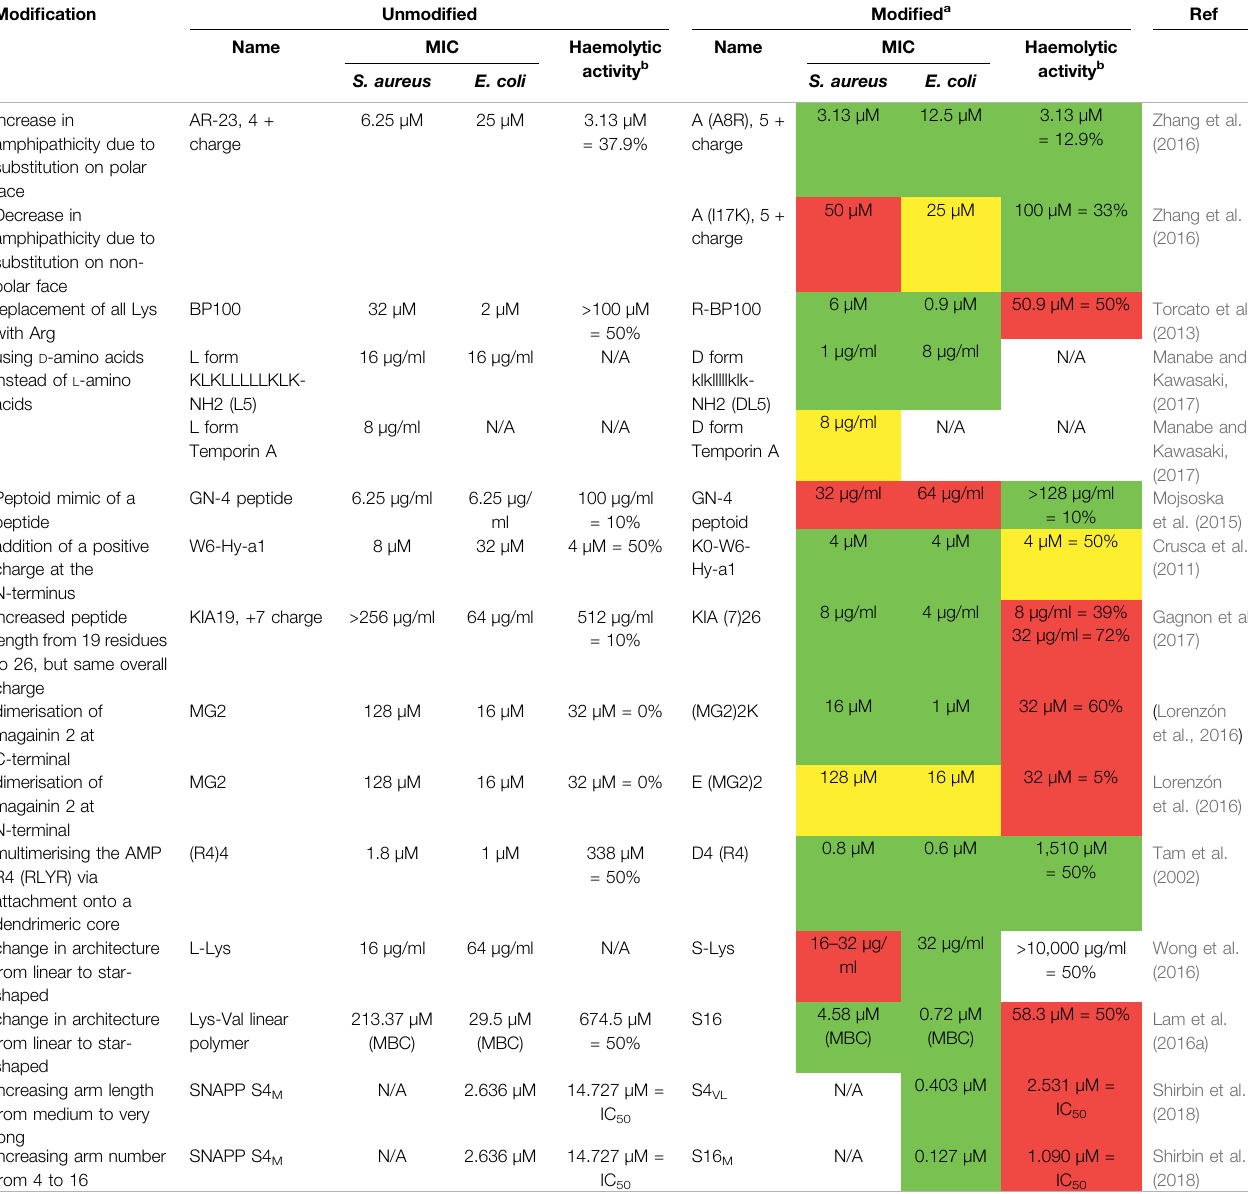
TABLE 1 | Summary of how different modi fi cations can increase or decrease the antimicrobial activity and toxicity of AMPs. Modi fi